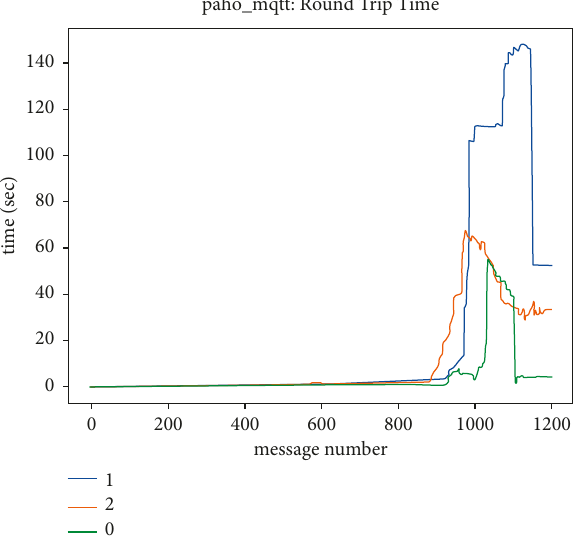
Figure 16: FastRTPS’s RTT with three communicating process pairs.